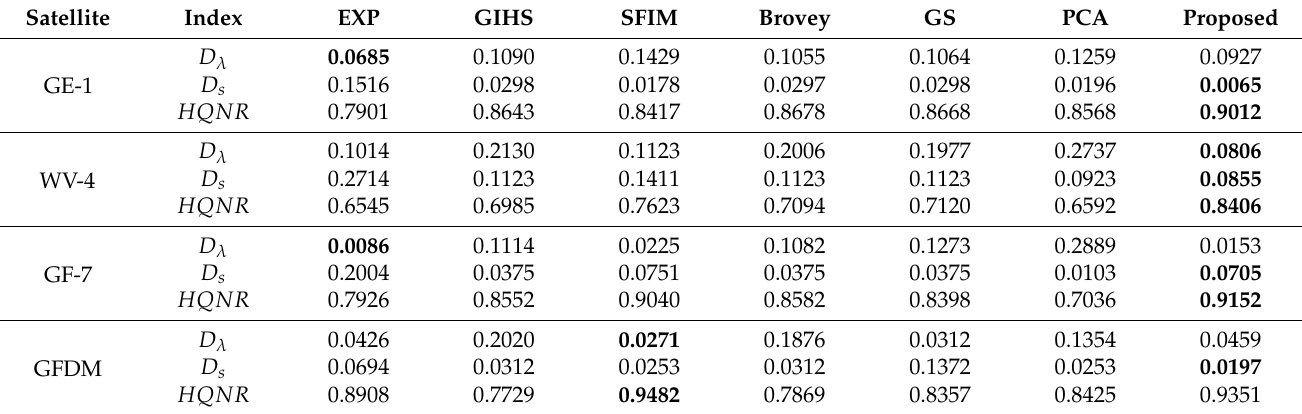
Table 6. Objective assessment indexes of fusion results without